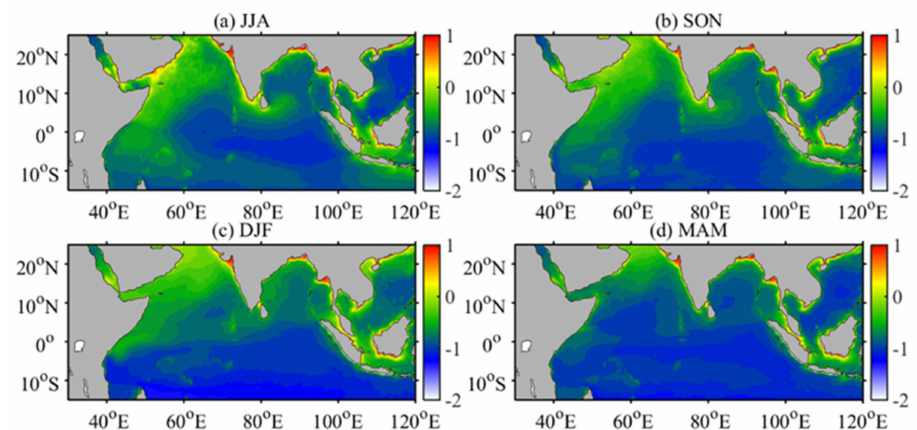
Figure 2. Seasonal average distribution of Chla in the Northern Indian Ocean during January 1998–December 2016 (unit: Log10, mg/m 3 ). ( a ) Summer (JJA); ( b ) autumn (SON); ( c ) winter (DJF); ( d ) spring (MAM).